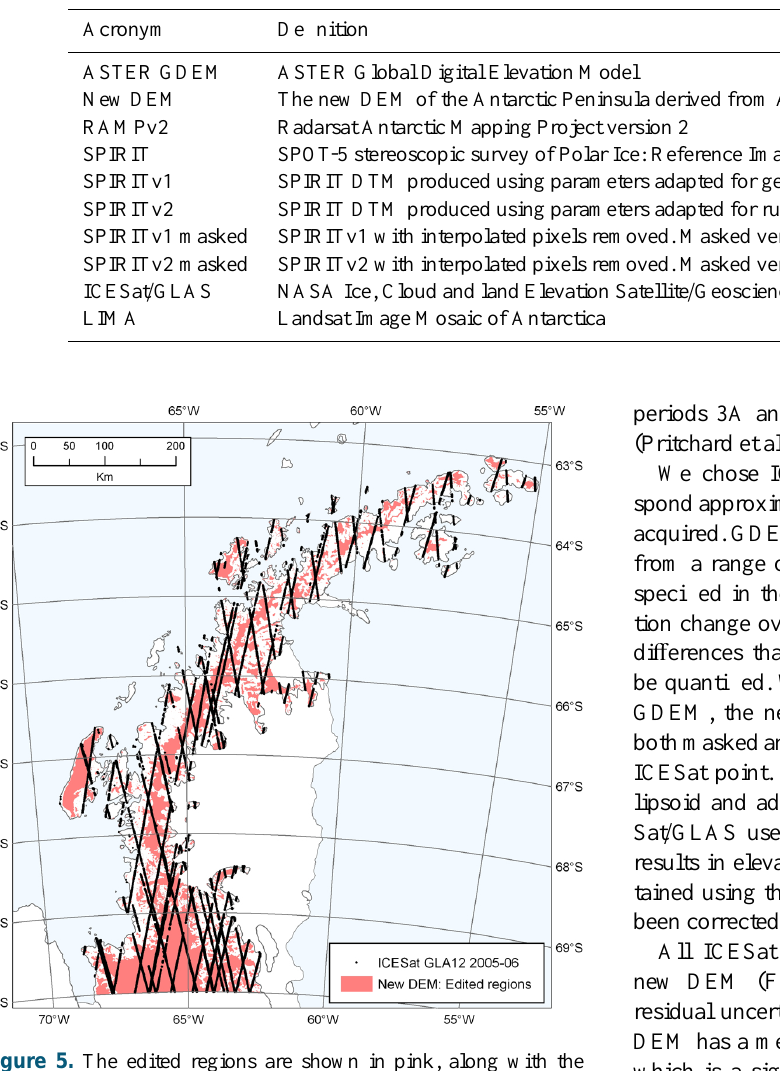
Table 1. Summary of dataset acronyms.